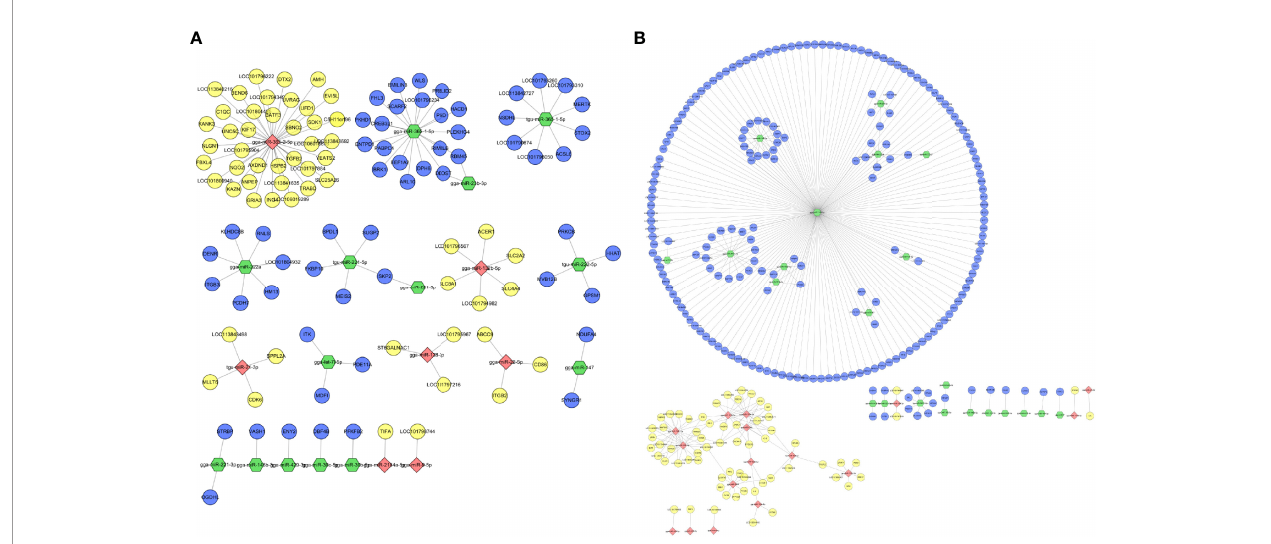
FIGURE 6 | Interaction network performed by negatively expressed miRNA – mRNA interaction pairs in DHAV-1-infected DEFs of D-vs.-N group (A) and H-vs.-N group (B) . Red points indicate downregulated miRNA, yellow points indicate upregulated mRNA, green points indicate upregulated miRNA, and blue points indicate downregulated